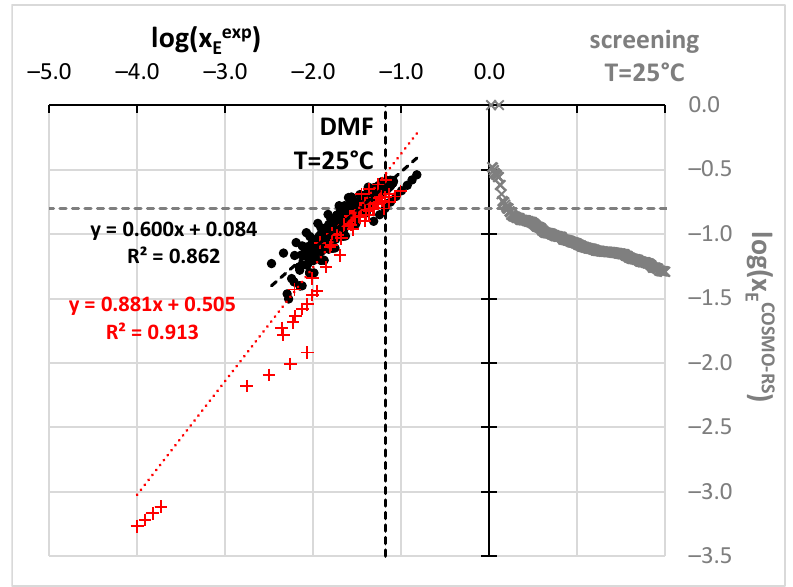
Figure 9. Results of ethenzamide solubility measurements and computations. Notation is the same as in Figure 2.